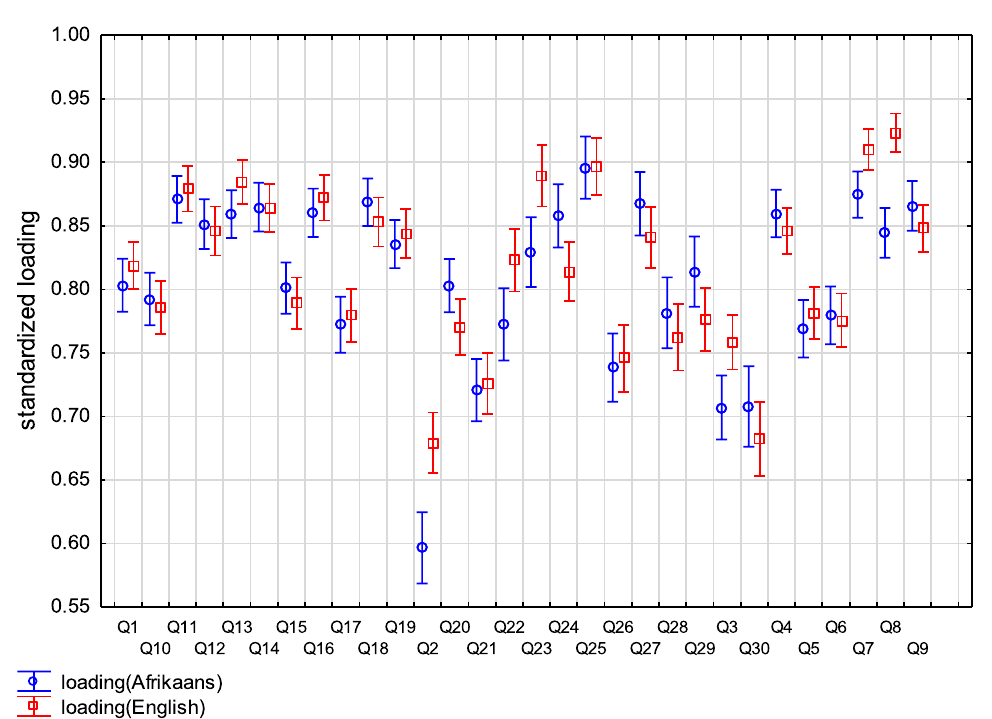
Fig. 2 Range plot of standardise loading between Afrikaans for the Western Cape and English DASH